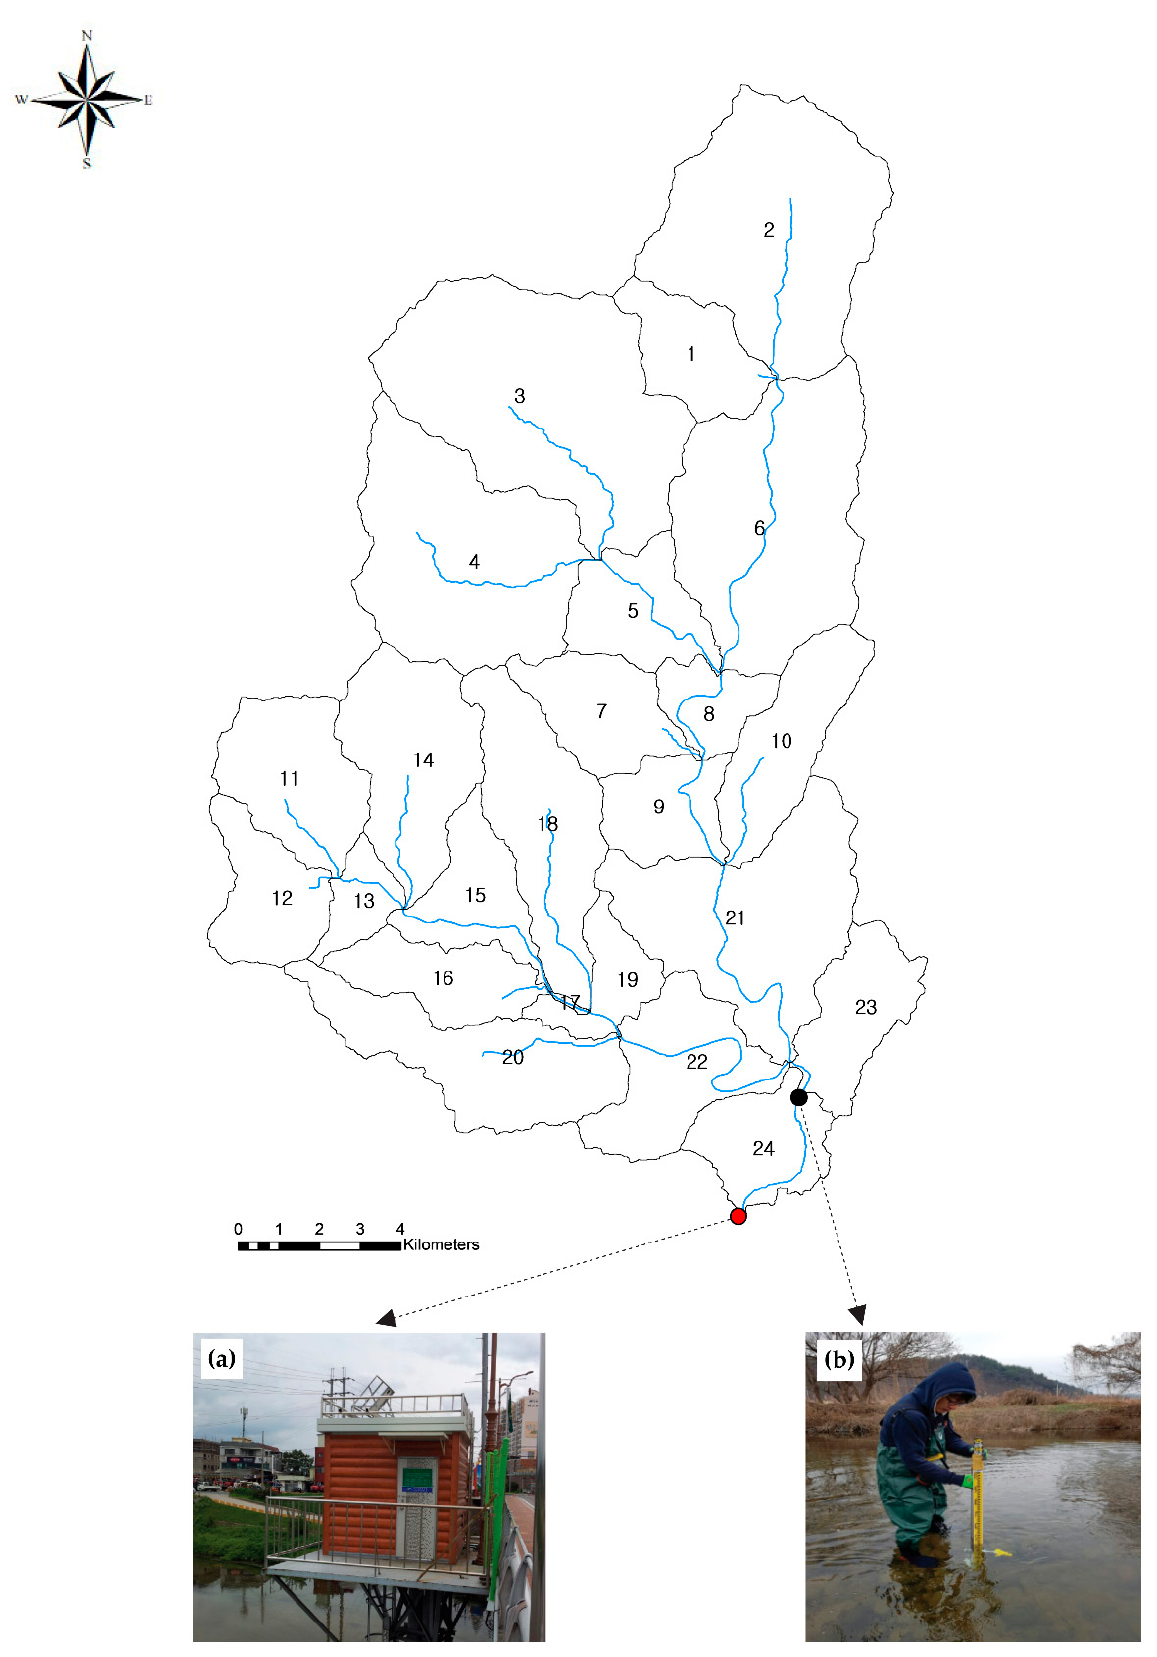
Figure 6. Division of subbasins. ( a ) Yecheon Bridge, Soil and Water Assessment Tool (SWAT) calibration point with gauged daily water level; ( b ) discharge measurement at the Yecheon Water Intake Station 4. Application and Analysis 4.1. Calculation of Long-Term Flow Using the SWAT Model This study reviewed the 10-year water level and flow data at the MOE Yecheon Wa- ter Level Gauging Station to acquire reliable daily flow data and determined whether a water level flow rating curve exists. For this study, the 2007 water level data were deter- mined to be available for removing artificial factors, such as the opening of weir gates,